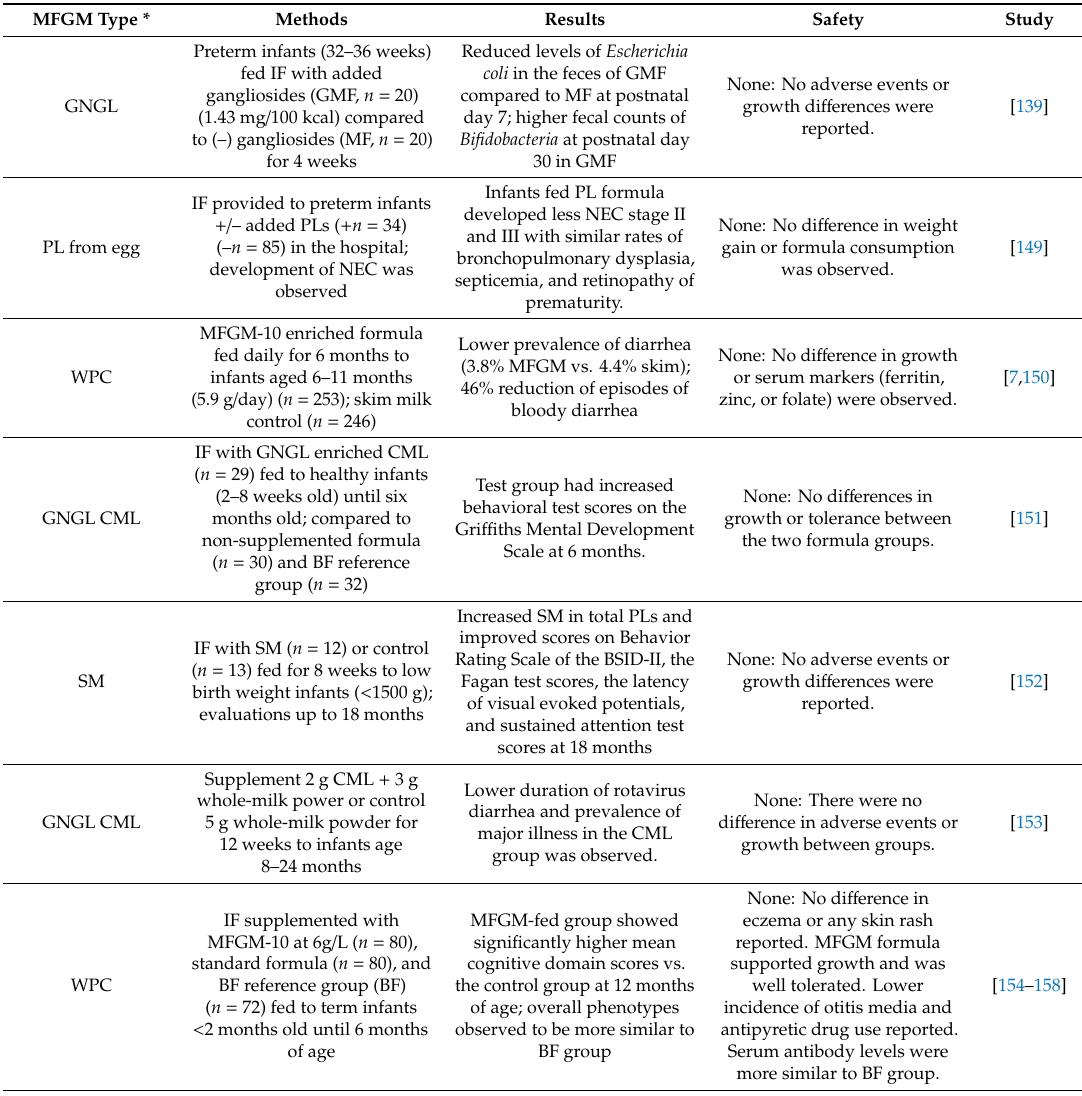
Table 5. Summary of clinical research studies on MFGM and its component for infants and young children. * MFGM is classified into various types depending on its source or the bioactive components: ganglioside enriched (GNGL), phospholipids, whey protein concentrate (WPC), complex milk lipids (CML), and sphingomyelin